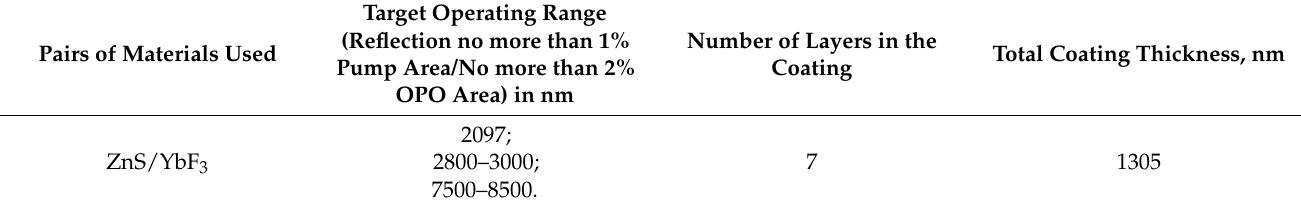
Table 2. Theoretical and experimental AR coatings parameters.